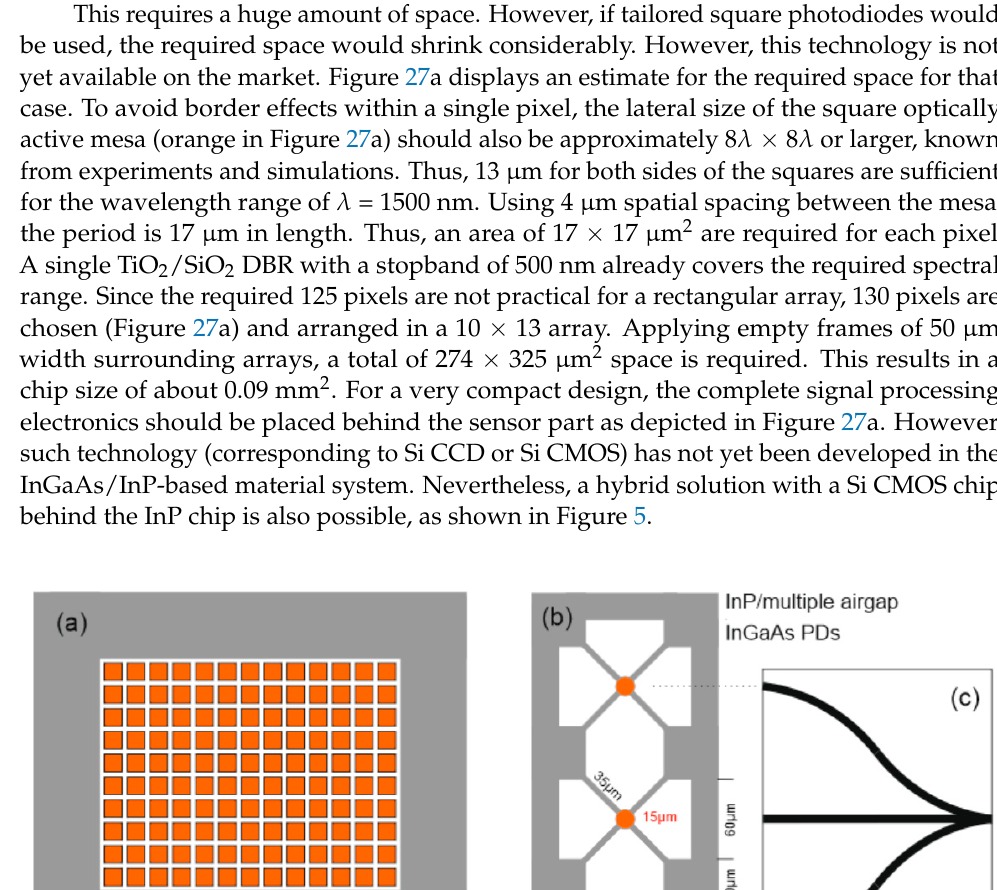
Figure 26. Space requirement to cover 500 nm in the NIR spectral range using commercial InGaAs PDs. Please note that this array is considerably scaled down in size compared to Figures 25 and 27.